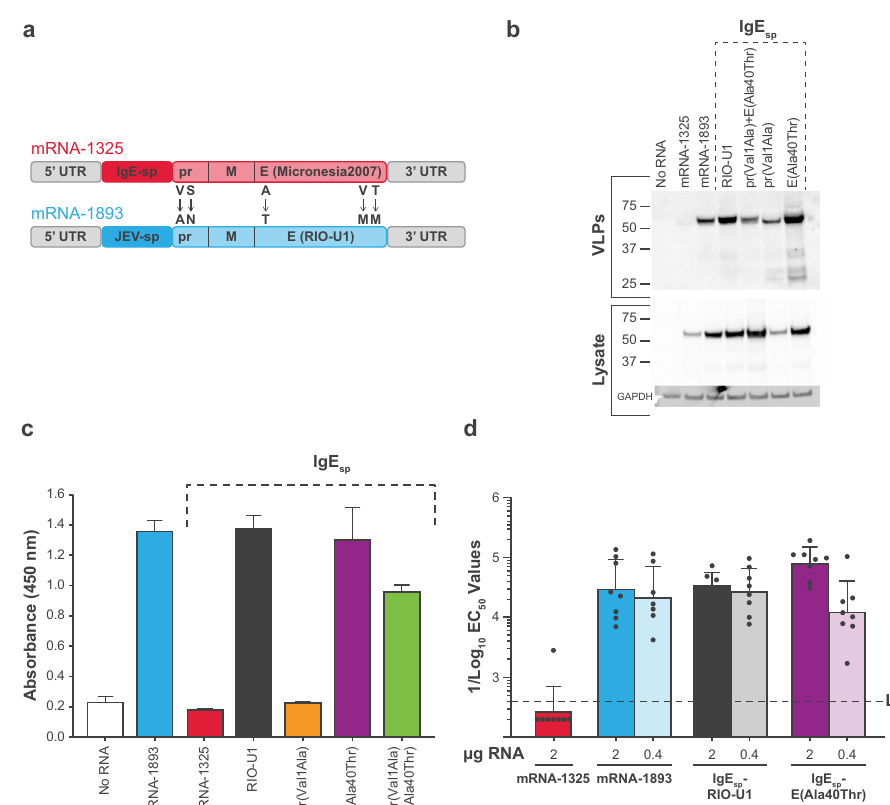
Fig. 3 VLP formation for an alanine to threonine substitution in the mRNA-1325 E ORF. a mRNA-1325 and mRNA-1893 differ in signal sequences and 5 amino acid residues within the prME ORF. b Cell lysates and VLP pellets were blotted for E protein using ZV-116 antibody. GAPDH was used as a loading control. Molecular weights were estimated using Precision Plus Dual Color Standards (Bio-Rad). c VLP secretion from transfected cells was measured in a sandwich ELISA with ZV-117 antibody, followed by ZV-67 antibody, and an anti-mouse HRP- conjugated secondary antibody. d Colored bars represent GMT for the group, and black circles represent individual animals ( n = 8 per group). Error bars indicate SD from the GMT. Dashed line indicates assay LOD. E, envelope; EC 50 , half-maximal effective concentration; ELISA, enzyme- linked immunosorbent assay; GMT, geometric mean titer; HRP, horseradish peroxidase; IgE, immunoglobulin E; JEV, Japanese encephalitis virus; LOD, limit of detection; ORF, open reading frame; prME, premembrane/membrane and envelope; RVP, reporter virus particle; SD, standard deviation; UTR, untranslated region; VLP, virus-like particle; ZIKV, Zika